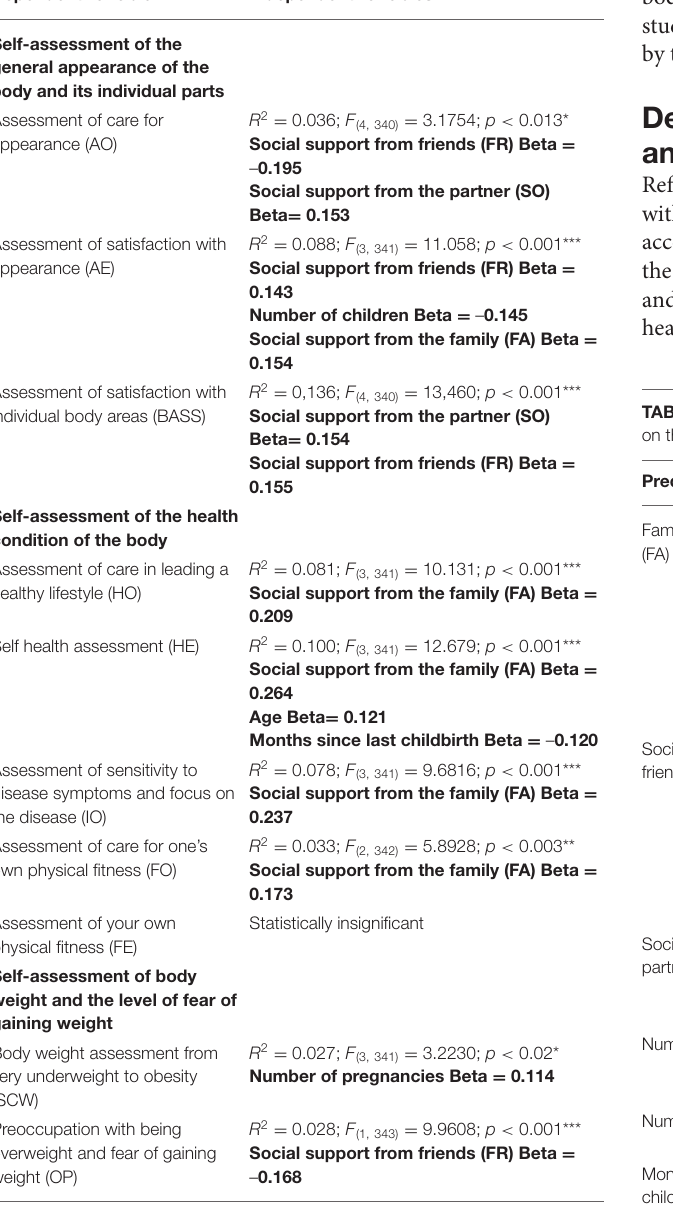
TABLE 5 | Summary of regression models for psychosocial variables and their significant predictors in the research group of women diagnosed with DRAM ( n =